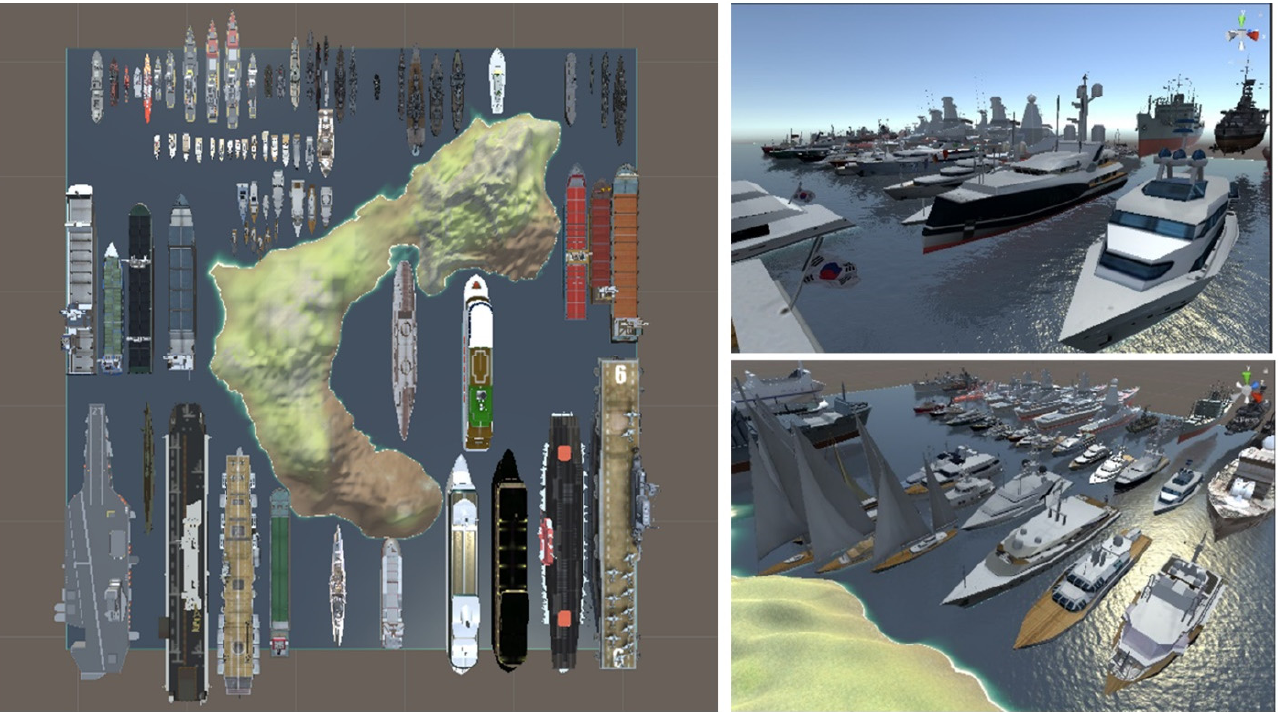
Figure 1. Examples of ship models, including ten categories and 79 kinds of ship models.